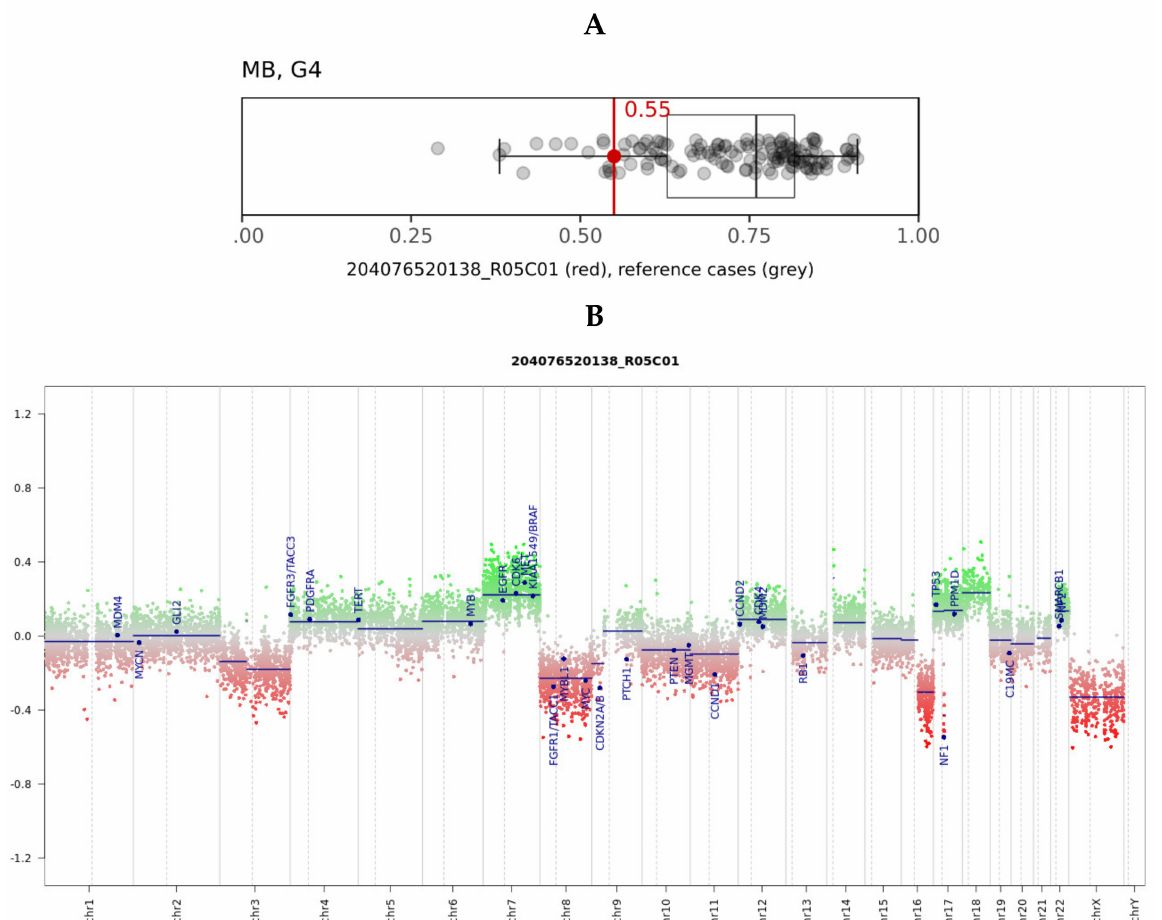
Figure 2. ( A ) Box and whisker plots depict the maximum raw classification scores (0.55) of the tumor sample in the methy- lation class “methylation class medulloblastoma, subclass group 4 (MB, G4)”, according to brain tumor classifier v11b4. Grey dots represent the reference cases in the methylation class. ( B ) Copy number variation plots were calculated from the DNA to 22 and X. Gains/amplifications represent positive (green), and losses negative (red), deviations from the baseline. Twenty-nine brain tumor-relevant genomic regions are highlighted. The red arrow points out the deleted chromosome 17q region, including the NF1